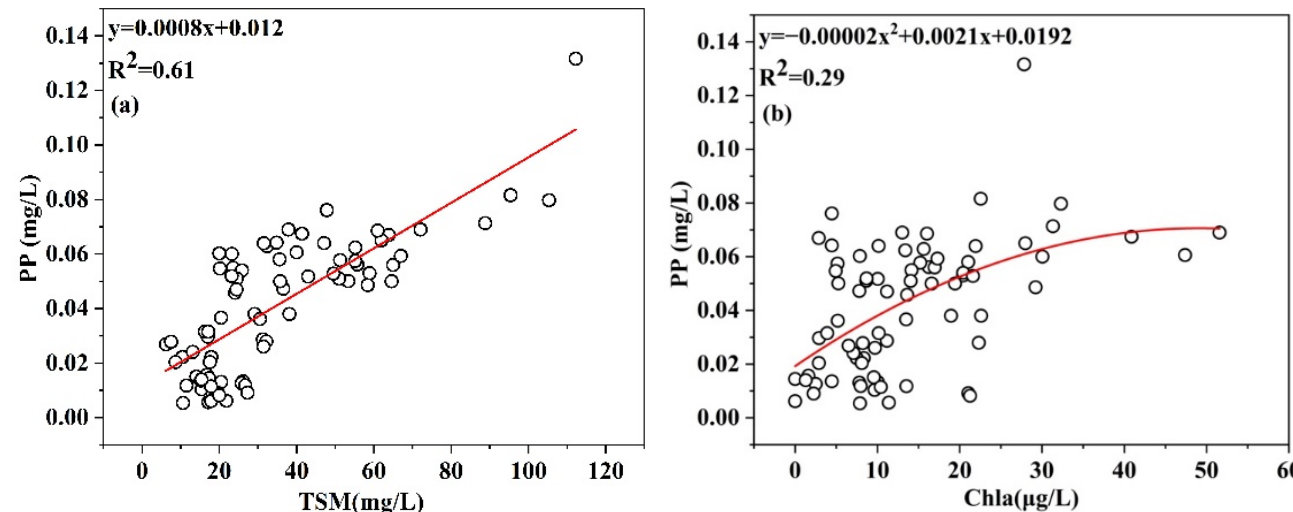
Figure 8. ( a ) The PP and TSM fitting curve; ( b ) the PP and Chl-a fitting curve.